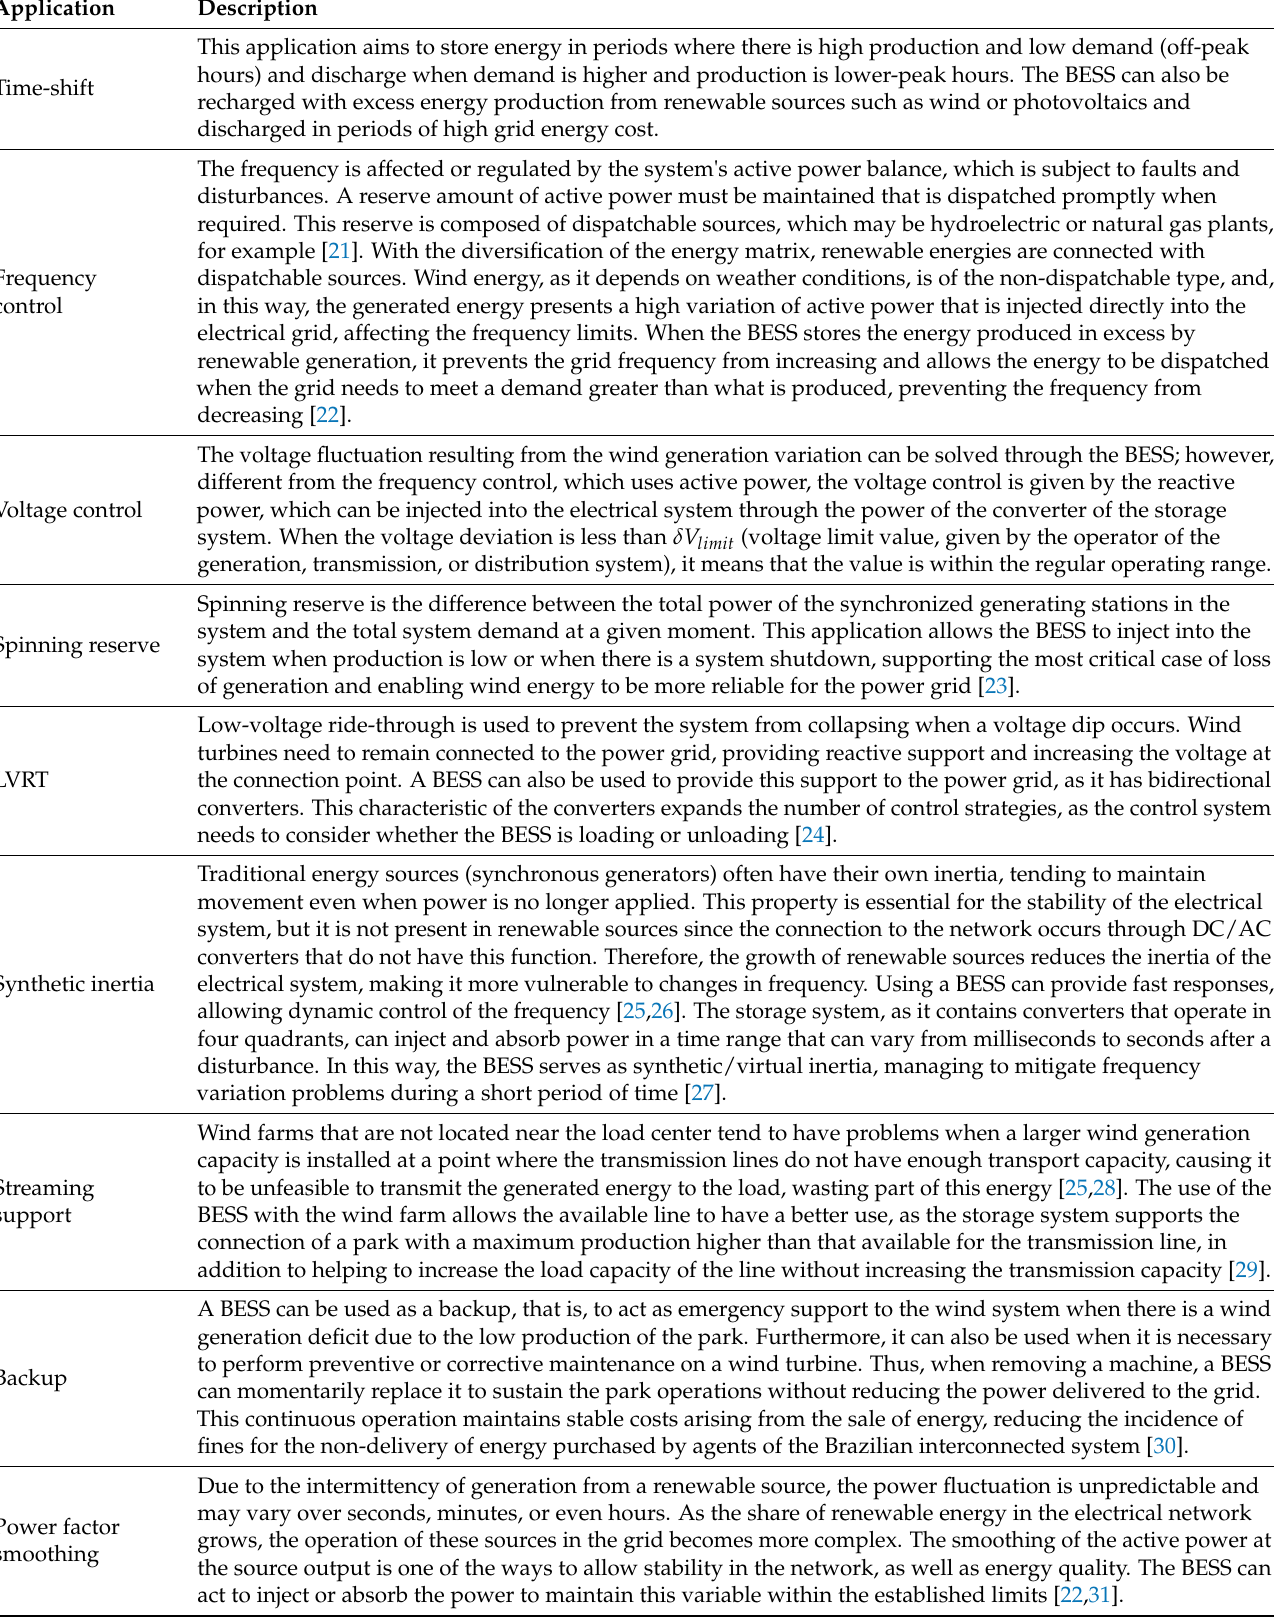
Table 1. Description of BESS applications in wind